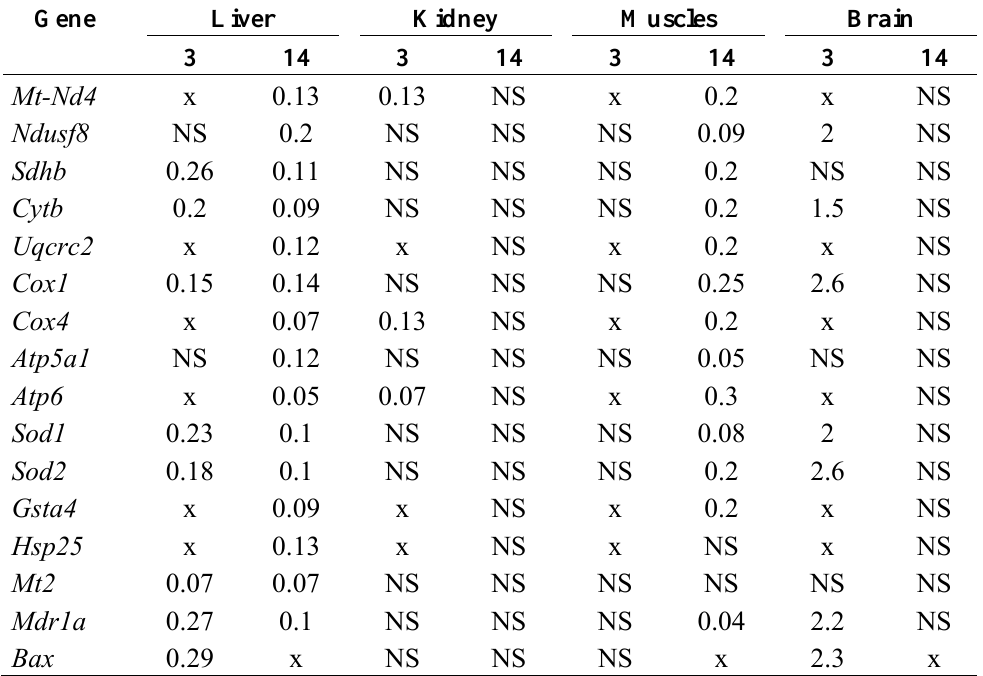
Table 10. Differential expression in tissues of mice fed the aimara-containing diet after 3 or 14 months exposure.